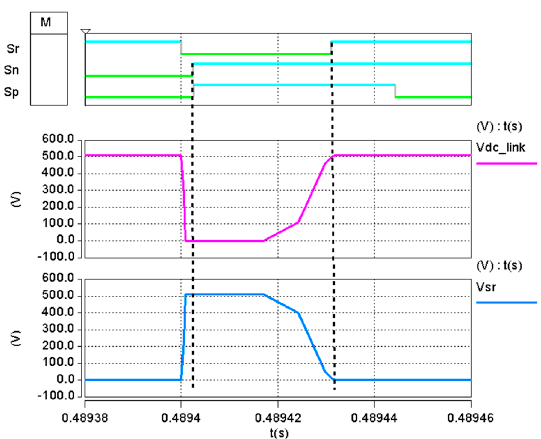
Figure 10. ZVS on main and auxiliary switches.